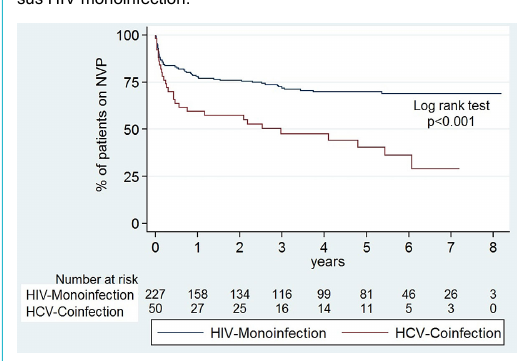
Figure 5: Kaplan-Meier survival curves: probability of remaining on nervirapine (NVP) with hepatitis C virus (HCV) co-infection ver- sus HIV